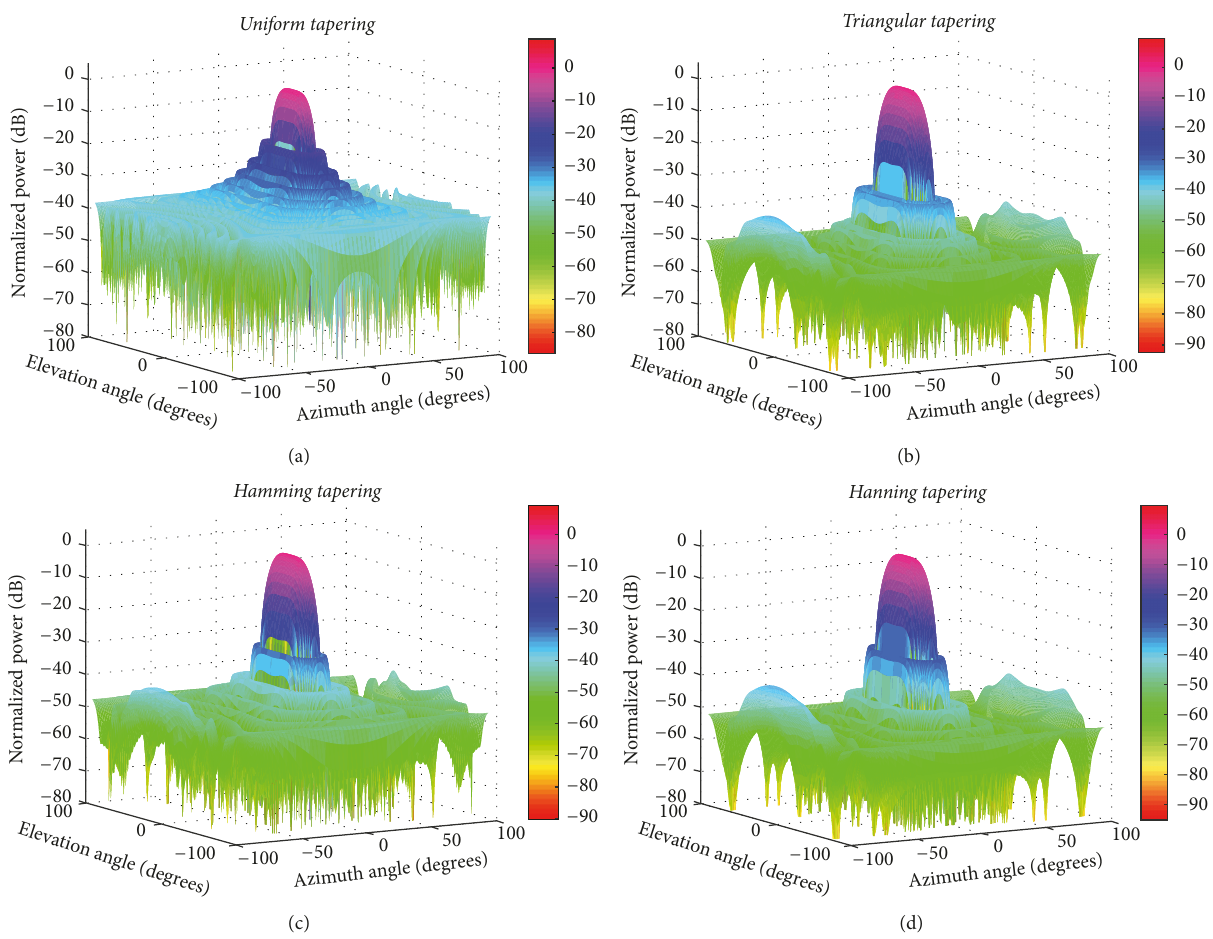
Figure 9: Normalized 3D output power patterns of (a) uniform tapered, (b) Triangular tapered, (c) Hamming tapered, and (d) Hanning tapered MVDR CECCAA beamformers with the variation of azimuth angle and elevation angle.